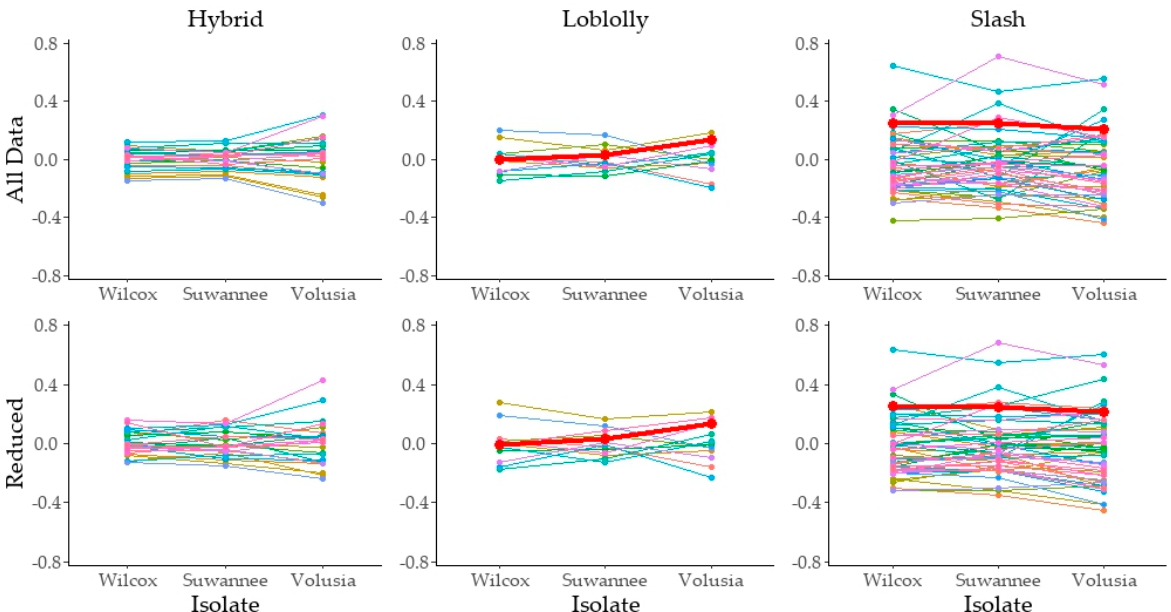
Figure 5. Interaction plot of BLUPs for parent and ancestors (i.e., excluding progenies) stratified by taxon for both the full and reduced (i.e., potential escapes excluded) data sets. Thick red bars indicate the internal RSC check lots: MVLB for loblolly and U17 for slash.